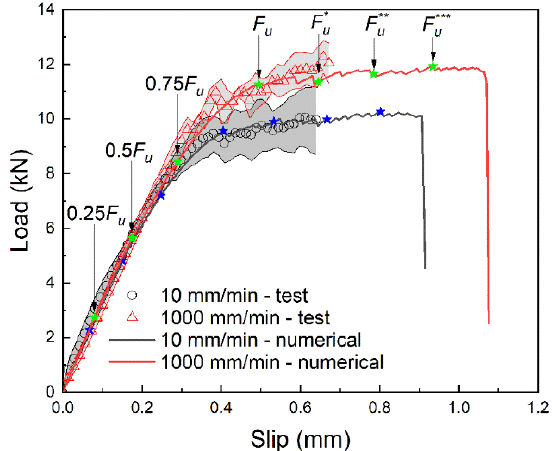
Figure 12. Comparison of load–slip curves between numerical and test.